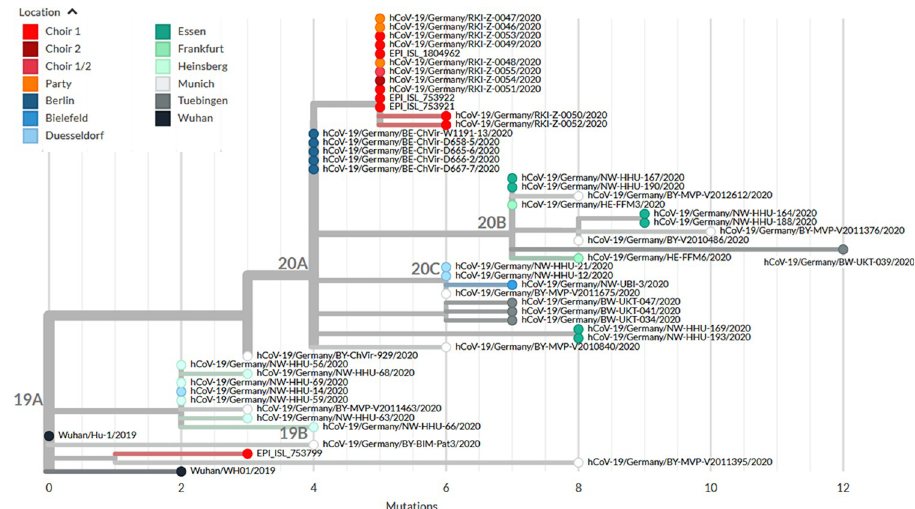
Fig 4. Phylogenetic relationship between the outbreak strain (choir 1, choir 2, party), the aberrant strain (choir 1), and unrelated sequences from different locations in Germany, sampled until end of March 2020. Branch length given as number of mutations.